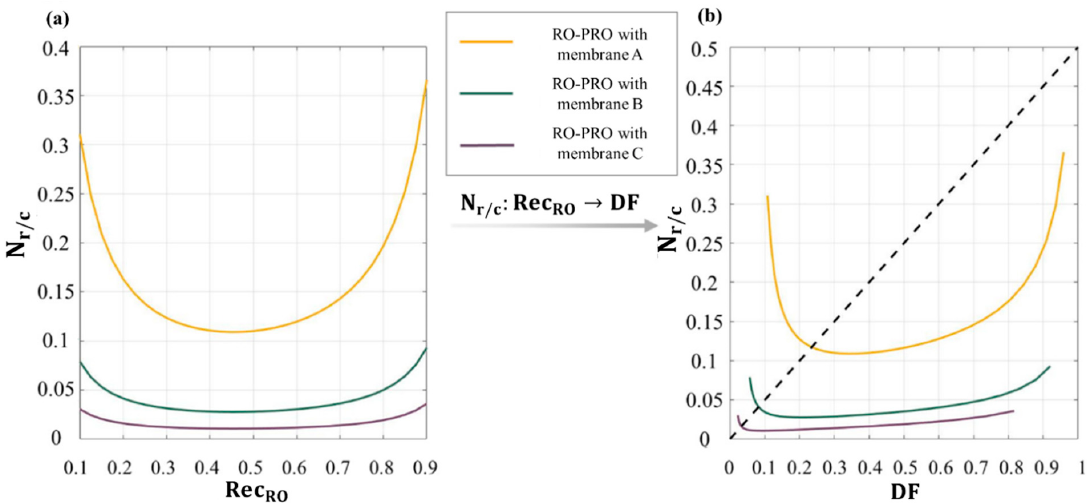
Figure 13. The variation of the dimensionless performance index ( N r / c ) for an RO-PRO hybridized process according to ( a ) the water recovery rate of RO ( Rec RO ), and ( b ) the dilutive factor of PRO ( DF ). Since DF is a function with respect to Rec RO , the trend of N r / c can be tracked along the change of DF . In this figure, membrane performances: membrane A > membrane B > membrane C; C F , b , RO = 35,000 ppm; η e = 0.90; and η p = 0.80